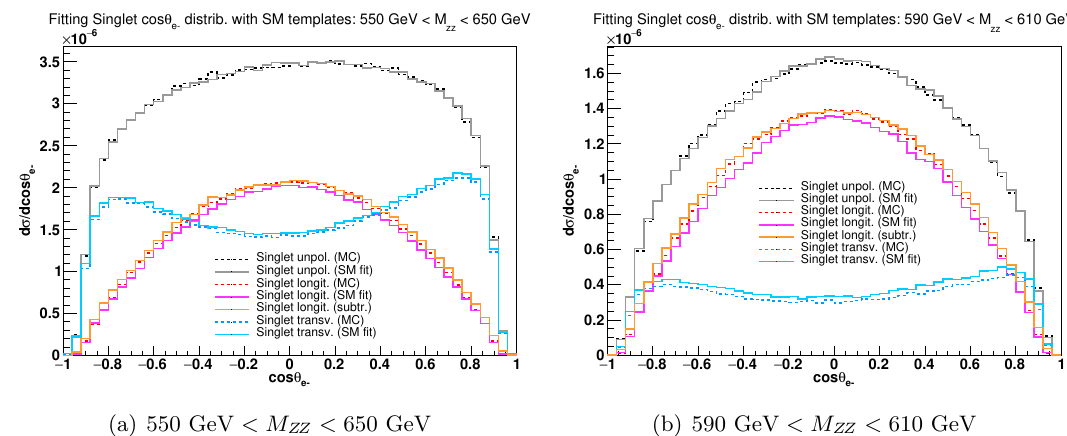
Figure 16 . ZZ scattering: (cid:12)t of Singlet unpolarized cos (cid:18) distribution with SM templates. Fitted e (cid:0) and expected di(cid:11)erential cross sections in two ZZ invariant mass windows about the heavy Higgs pole mass. For the longitudinal component the result of the (cid:12)t (magenta) and the subtraction technique one (orange) are compared with the Monte Carlo expectation (dashed red).